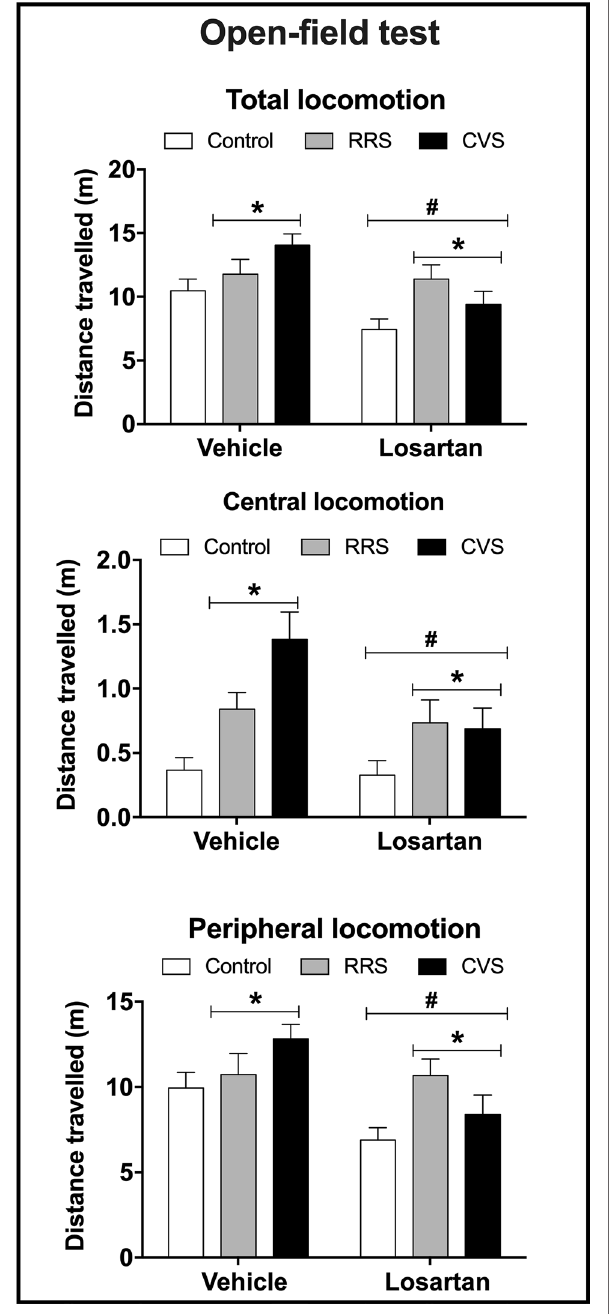
FIGURE 2 | Total locomotion (distance travelled in the periphery + center, top graph) and distance travelled in the center (central locomotion, middle graph) and periphery (peripheral locomotion, bottom graph) in the open field apparatus in animals treated with either vehicle or losartan control (white bars) and subjected to RRS (gray bars) or CVS (black bars). The bars represent the mean ± SEM. *P < 0.05 vs respective control group, # P < 0.05 vs respective vehicle groups. Two-way ANOVA followed by Bonferroni post-hoc test (n =